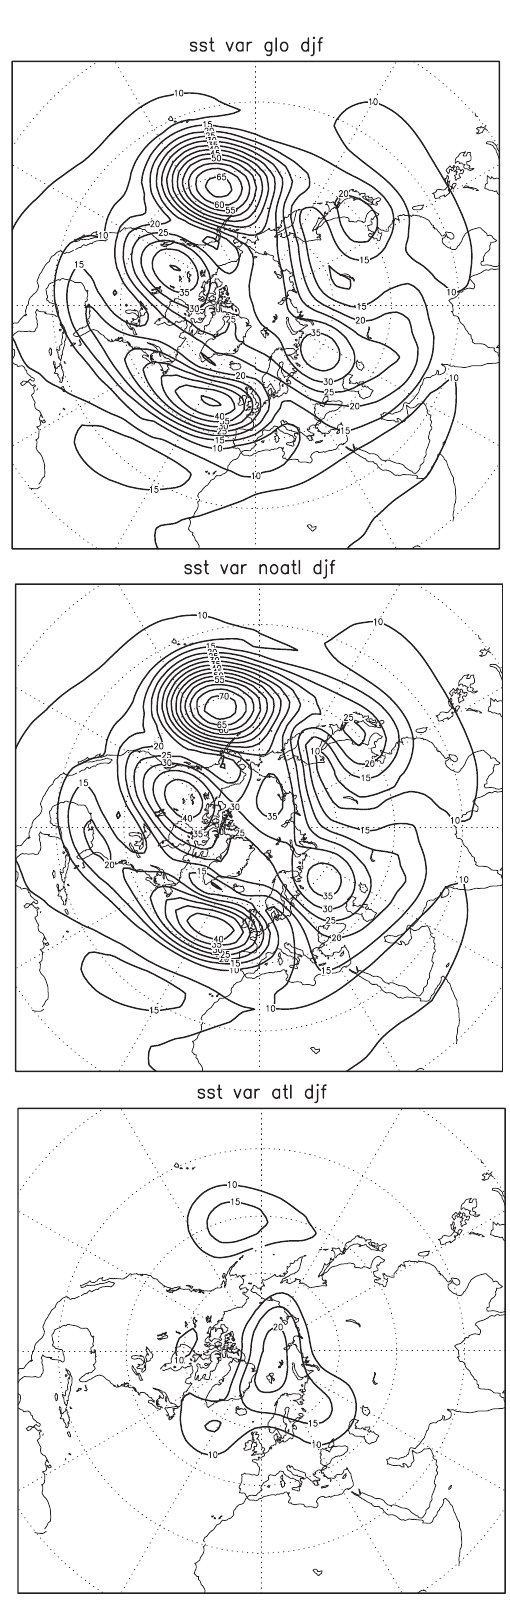
Fig. 3. Same as in fig. 1, but for the external forced